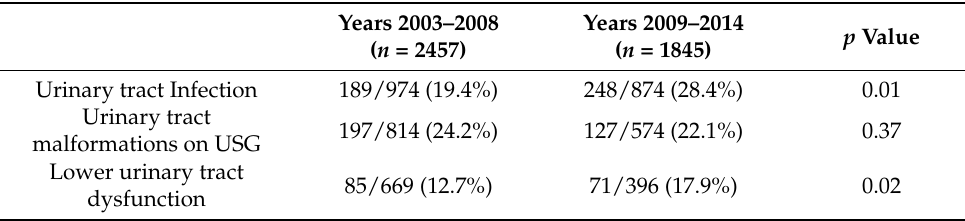
Table 3. Indications for VCG and positive reflux diagnosis in two time intervals (2003–2008